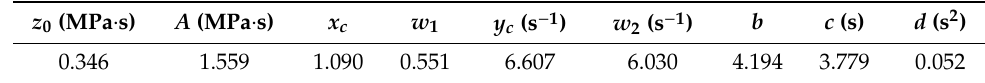
Table 2. Parameters of viscosity coe ffi cient.